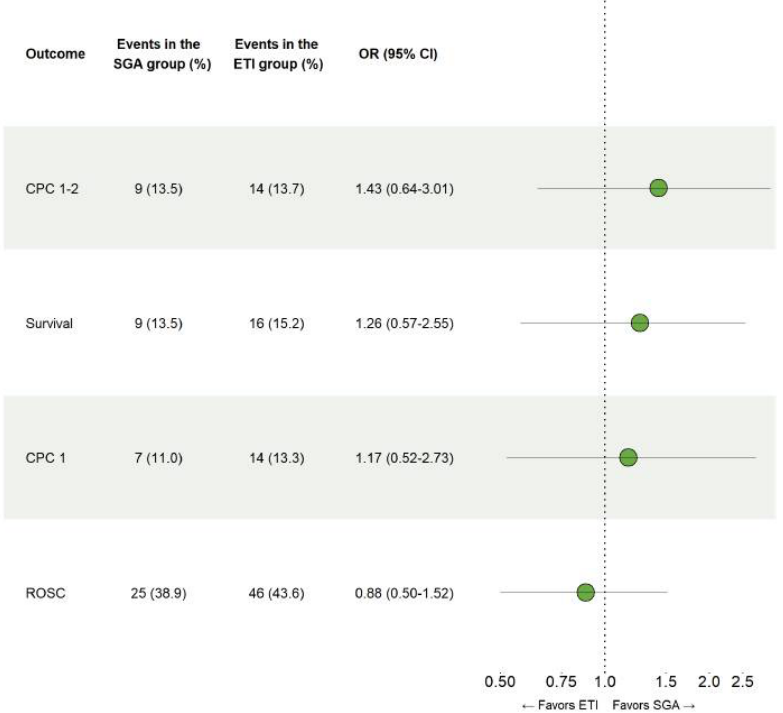
Figure 2. Comparison of endotracheal intubation and supraglottic airways. Results for the conditional logistic regression models that were fitted using propensity score matched data to examine the safety of ETI and SGA in patients with out-of-hospital cardiac arrest.